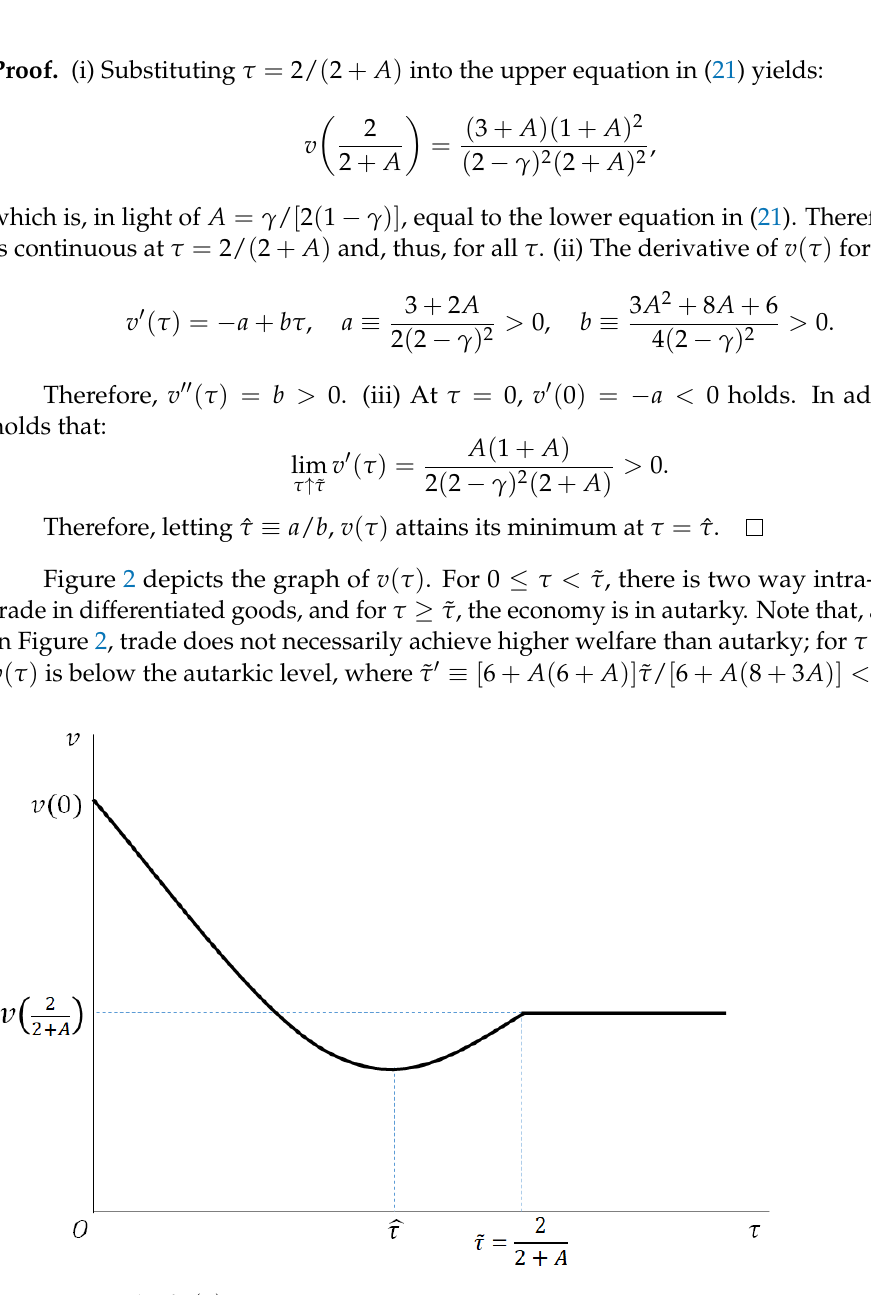
Figure 2. Graph of v ( τ )